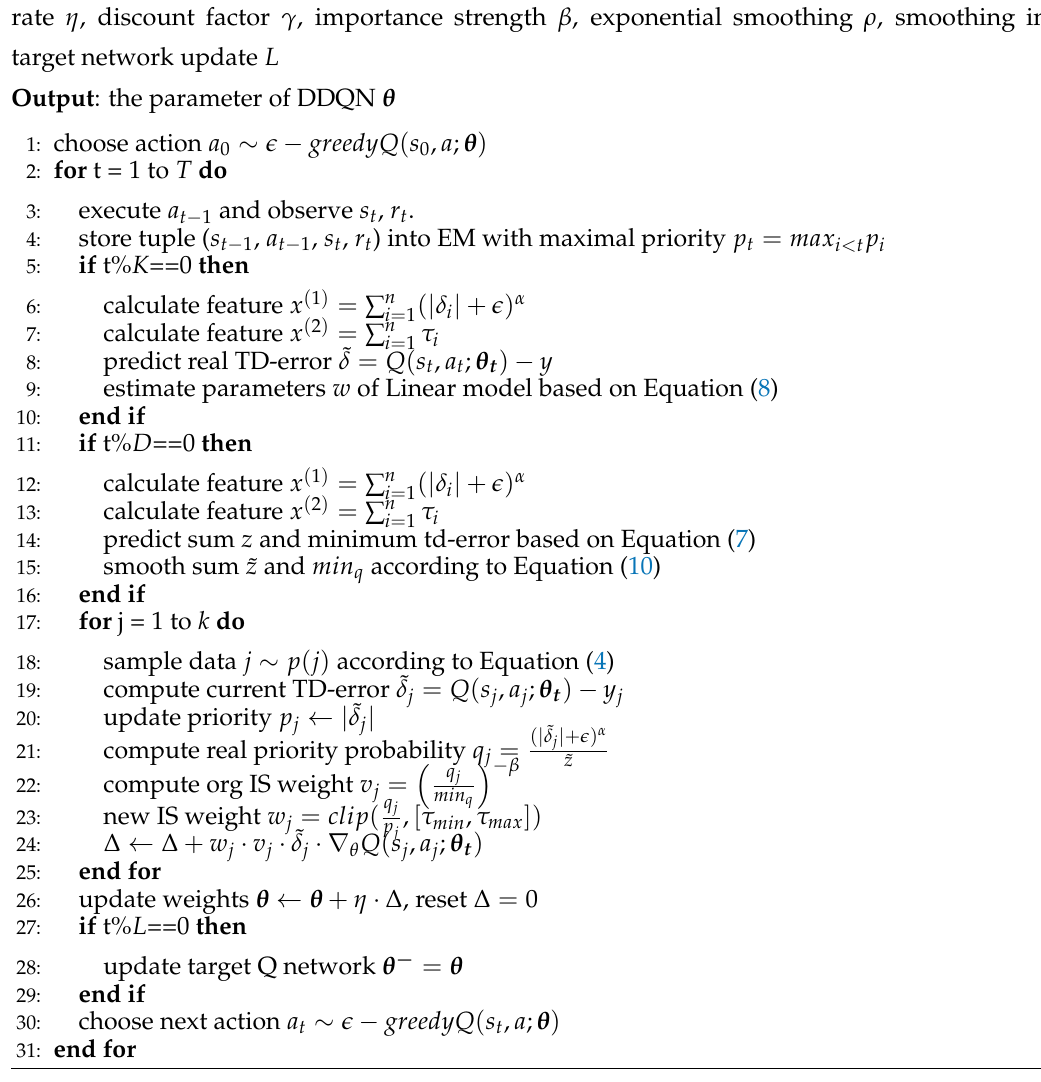
Algorithm 1 Double DQN with